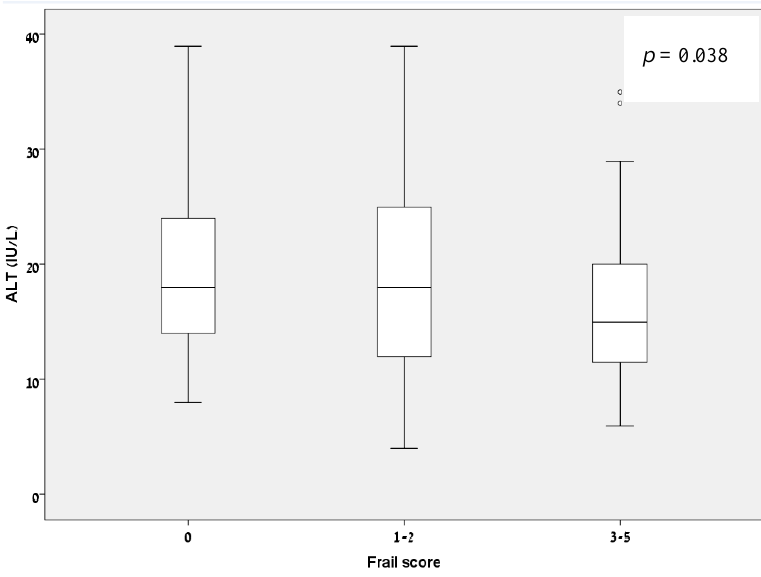
Figure 4. Low ALT values correlate with FRAIL Questionnaire groups.